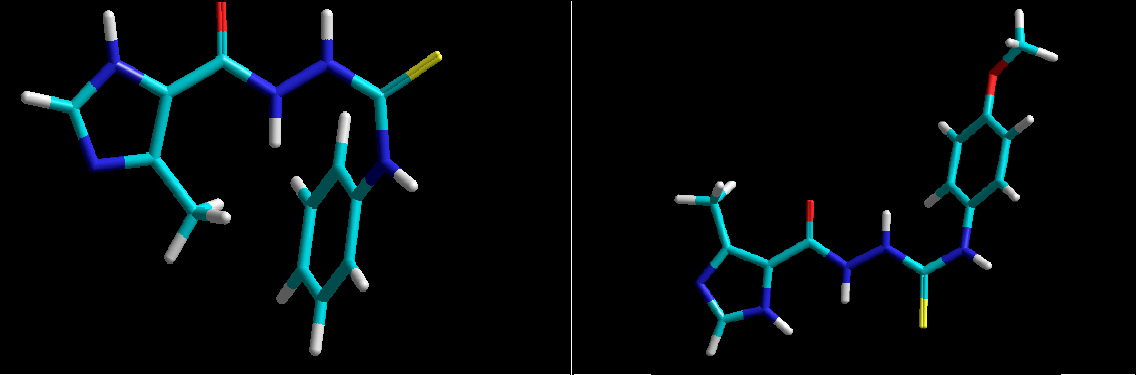
Figure 2. Structures of representative 4-aryl-1-(4-methyl-1H-imidazole-5- yl)carbonylthiosemicarbazides [21] with sulphur and oxygen atoms at C(=O)NHNHC(=S) core on the same side ( left ) or on the opposite side of the molecule ( right